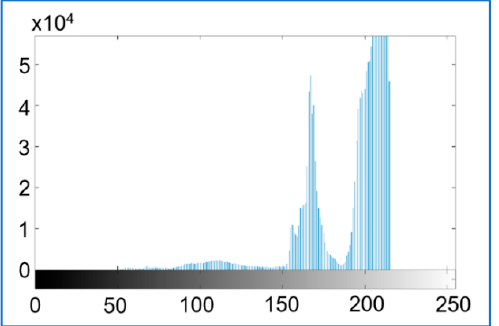
Figure 7. Gray histogram of Comprehensive image after gray weighted average.